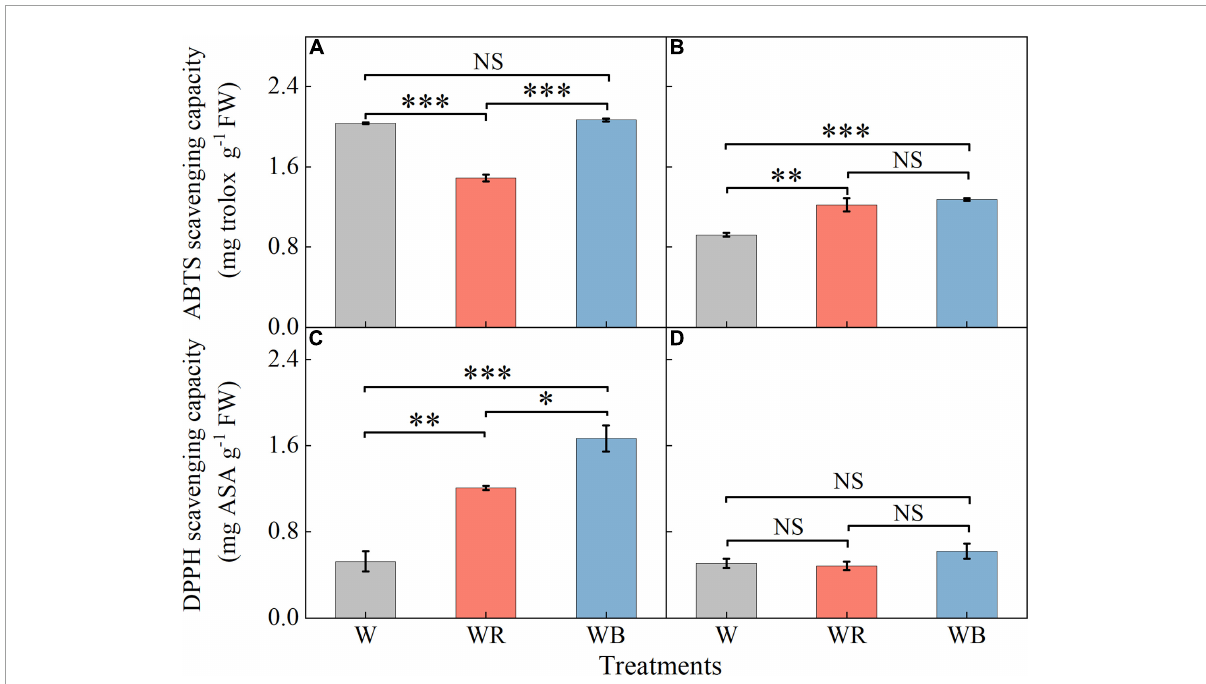
FIGURE7 The values of ABTS and DPPH scavenging capacity in extracts of wheat seedlings leaves (A,C) and stems (B,D) under different treatments. Values represent the mean ± SE ( n = 3). The symbols ∗ , ∗∗ and ∗∗∗ indicate significance at the 0.05, 0.01, and 0.001 levels, respectively. NS, not significant, according to the Duncan’s